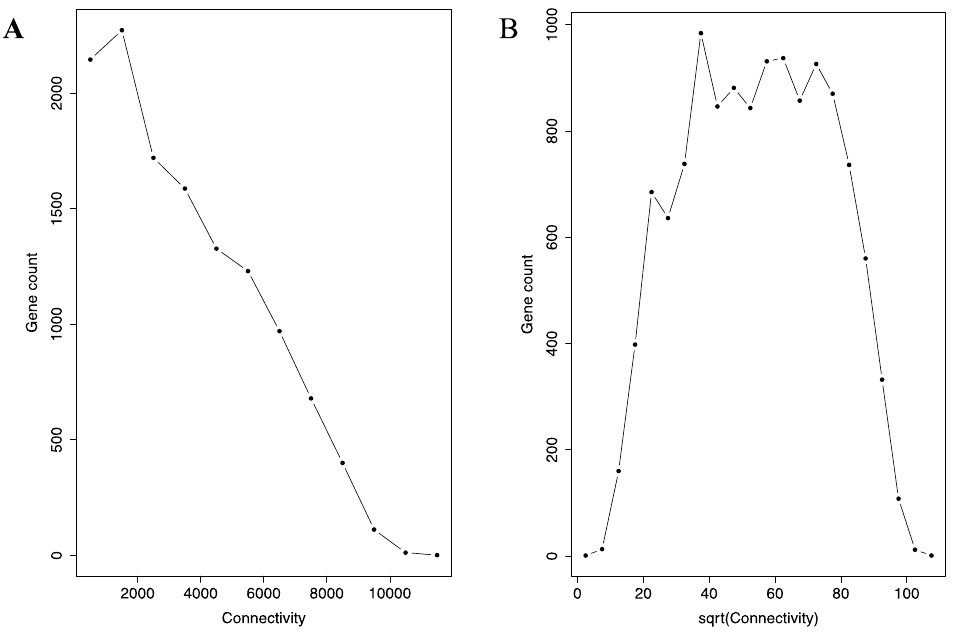
Figure 1. The connectivity distribution in the micro-RNA (miRNA) co-regulation network is similar to a square root distribution. The histogram of connectivity ( A ) and the square root (sqrt) of the connectivity ( B ) are shown. The connectivity histogram ( A ) is heavily right skewed, with a small portion of the genes having more than 10,000 connections and a much bigger portion with fewer than 2000 connections. Upon square root transformation, the histogram ( B ) becomes bell-shaped and approximately